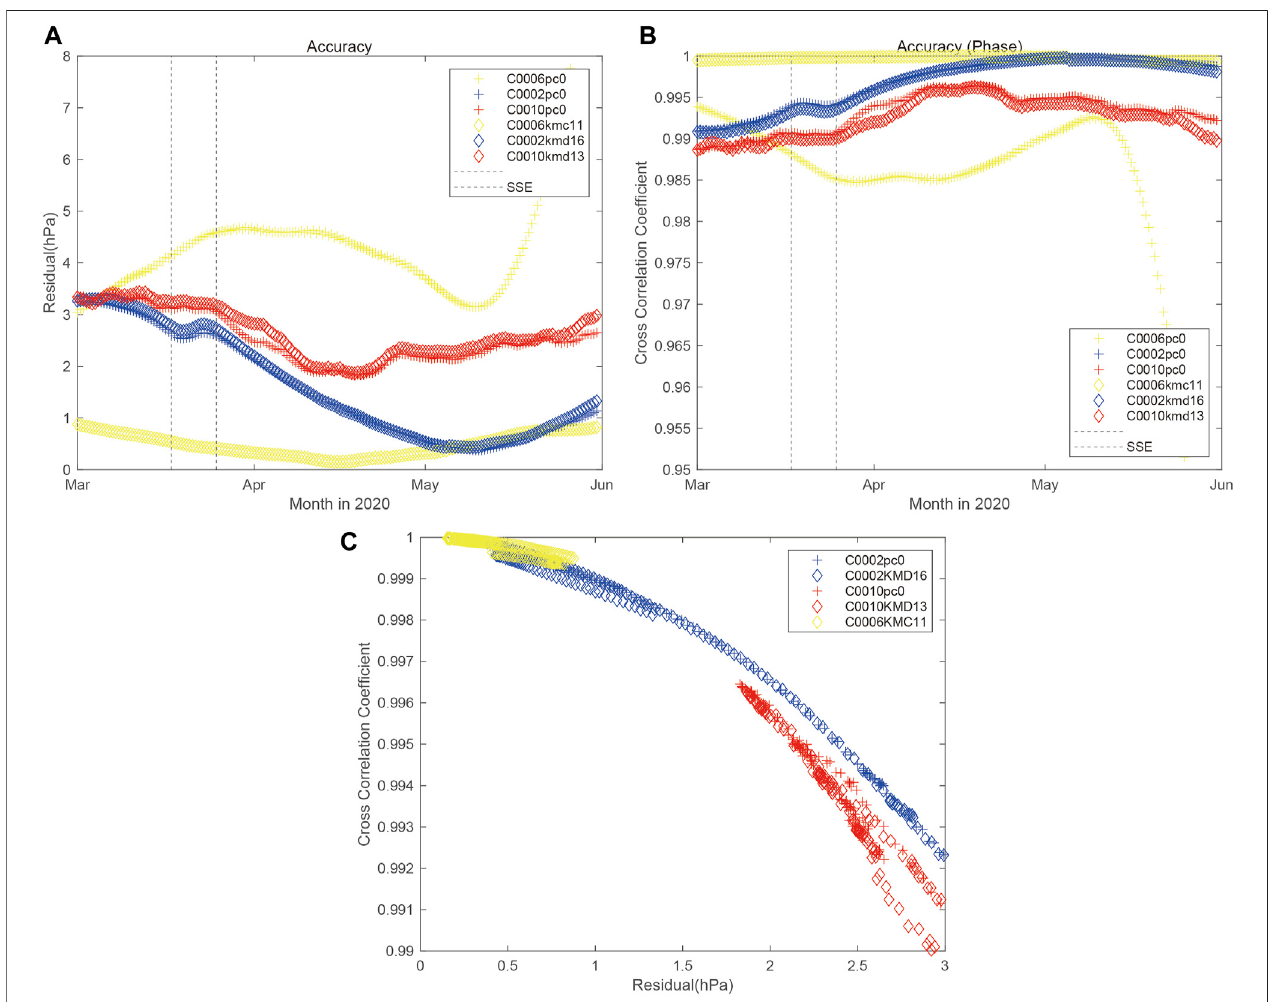
FIGURE6|(A,B) Timeseriesof (A) residual(L1norm)and (B) crosscorrelationcoef fi cientforeachcase.Theothersarethesameas Figure3 . (C) Scatterdiagram between (A) residual and (B) cross correlation coef fi cient.